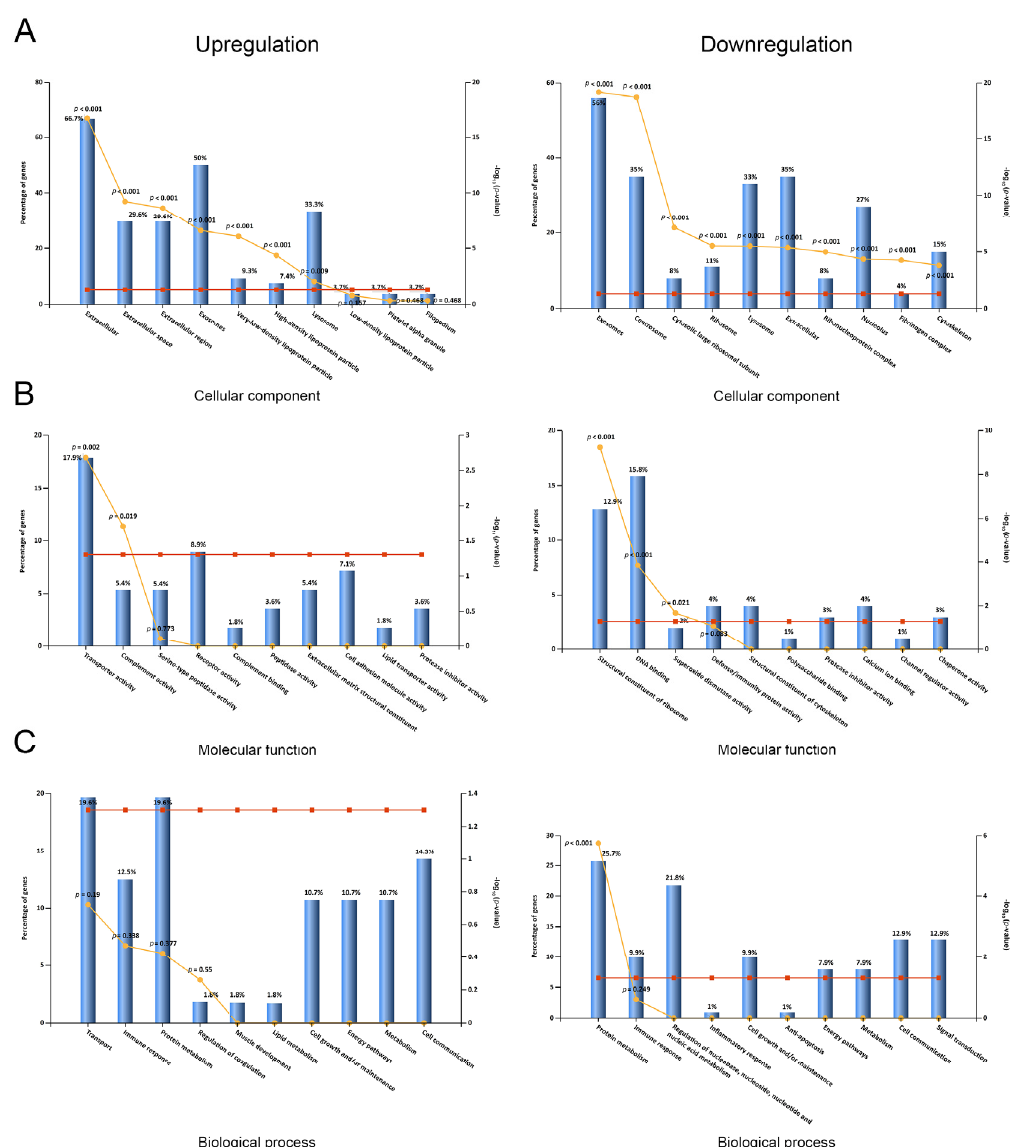
Figure 2. Subcellular localization and GO classification of serum DEPs. ( A ) Subcellular localization of serum proteins with upregulation and downregulation. ( B ) Molecular functions of GO classification of serum proteins with upregulation and downregulation. ( C ) Biological processes of GO classification of serum proteins with upregulation and downregulation.